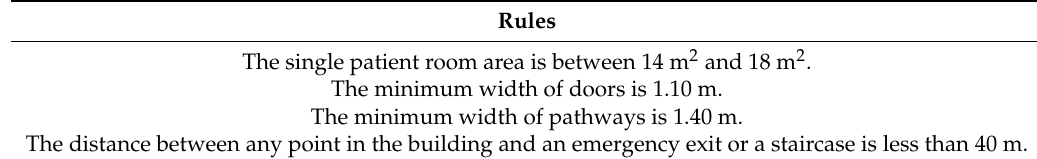
Table 5. An example of the healthcare code to be checked in the validation step.